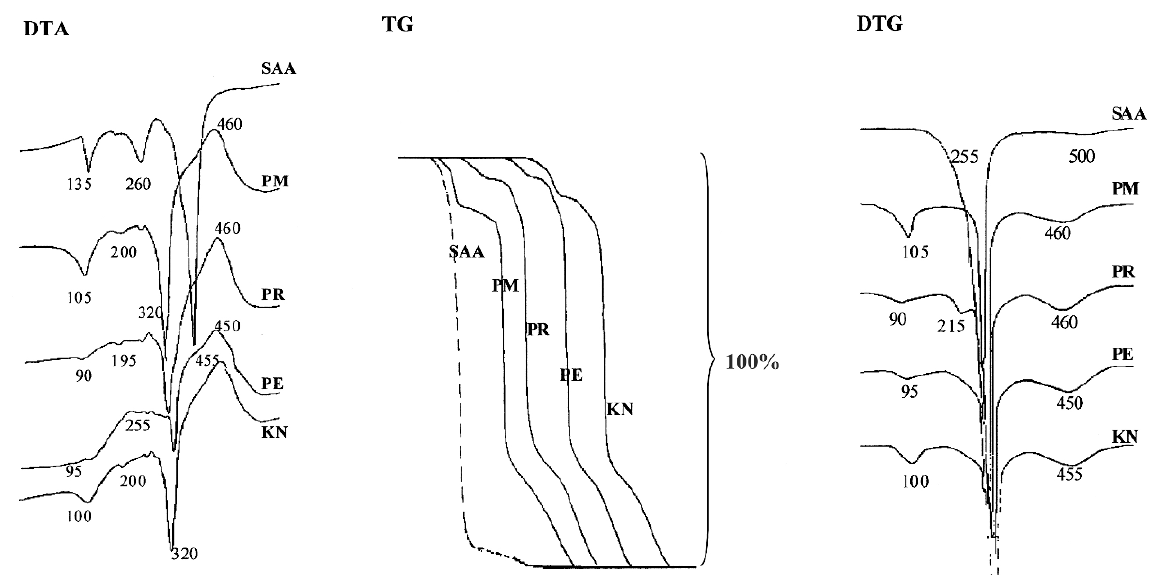
Figure 5. DTA, TG and DTG curves of salicylamide (SAA), its physical mixture (PM) and inclusion complexes (PR, PE, KN) with β